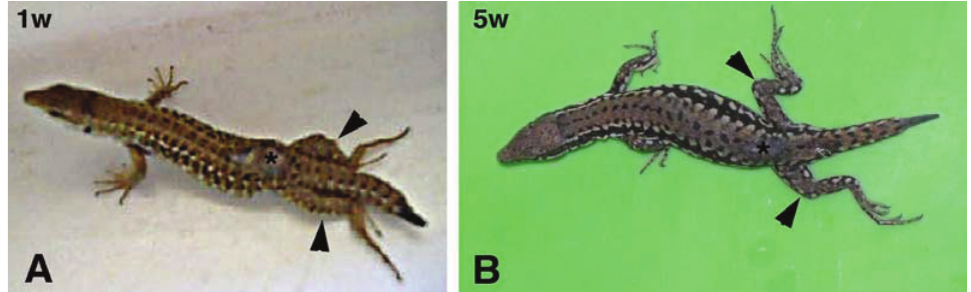
Figure 2. Examples of two lizards after one week ( A ) and five weeks ( B ) post-transection (asterisks indicate the point of transection). In A note the stiff hind limbs directed caudally (arrowheads). Note in B the folded hind limbs (arrowheads) showing a walking